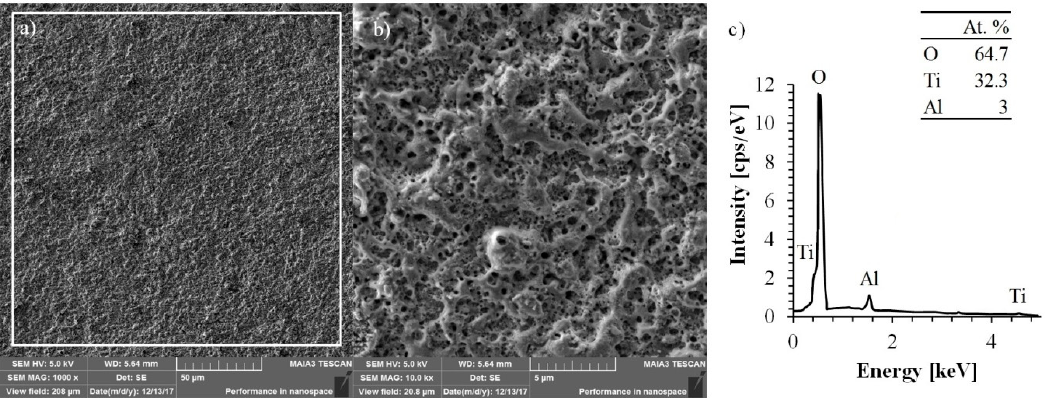
Figure 3. SEM image of surface morphology of the alloy Ti-6Al-4V treated by MAO with magnification: ( a ) 1000×; ( b ) 10,000× and ( c ) the elemental composition obtained by EDS.